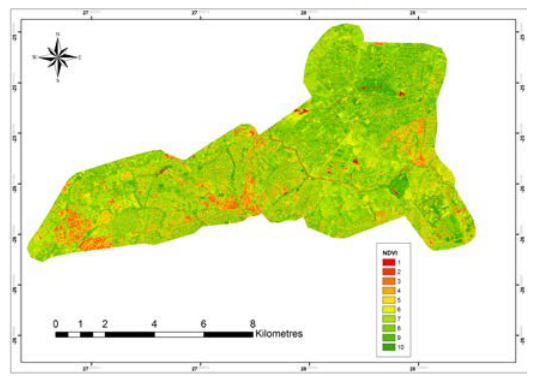
Figure 6: Illustration of NDVI derived classification for the study area